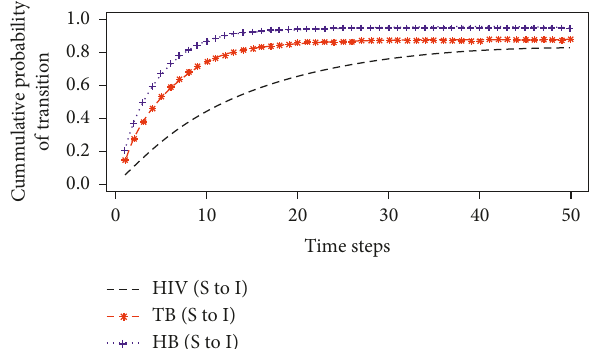
Figure 3: Probability of infection over the years for infected